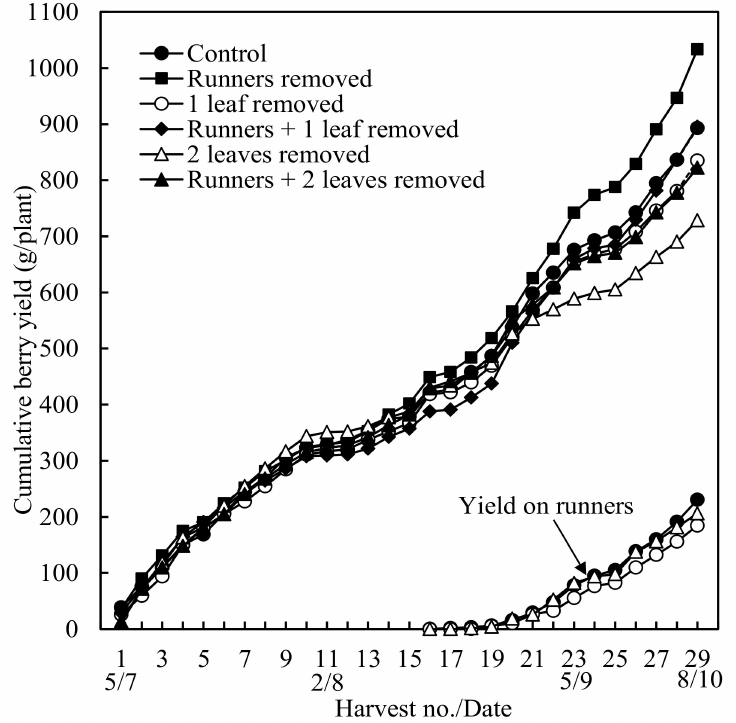
Figure 2. Time course of cumulative berry yield (g per plant, as average of three replicates with six plants each) in the everbearing strawberry cv. ‘Favori’ depending on bi-weekly removal of runners and leaves during the season.